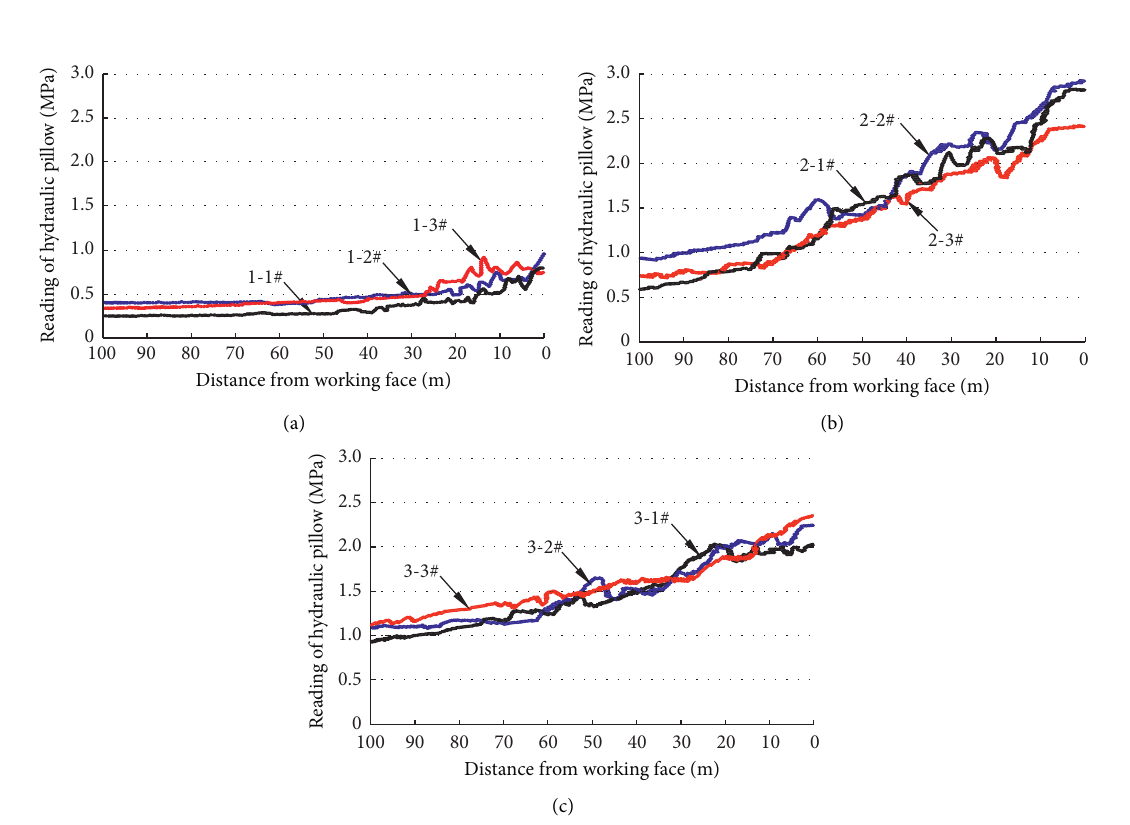
Figure 11: Stress state curve of the filling body during the reuse period of gob-side entry retaining. (a) Stress state of the filling body at station 1, (b) stress state of the filling body at station 2, and (c) stress state of the filling body at station 3.